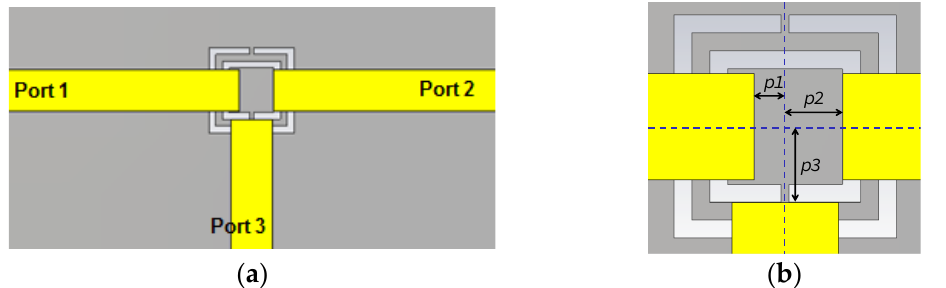
Figure 11. ( a ) Top view SCSRR single layer power divider. ( b ) Detail of microstrip lines position over the SCSRR.